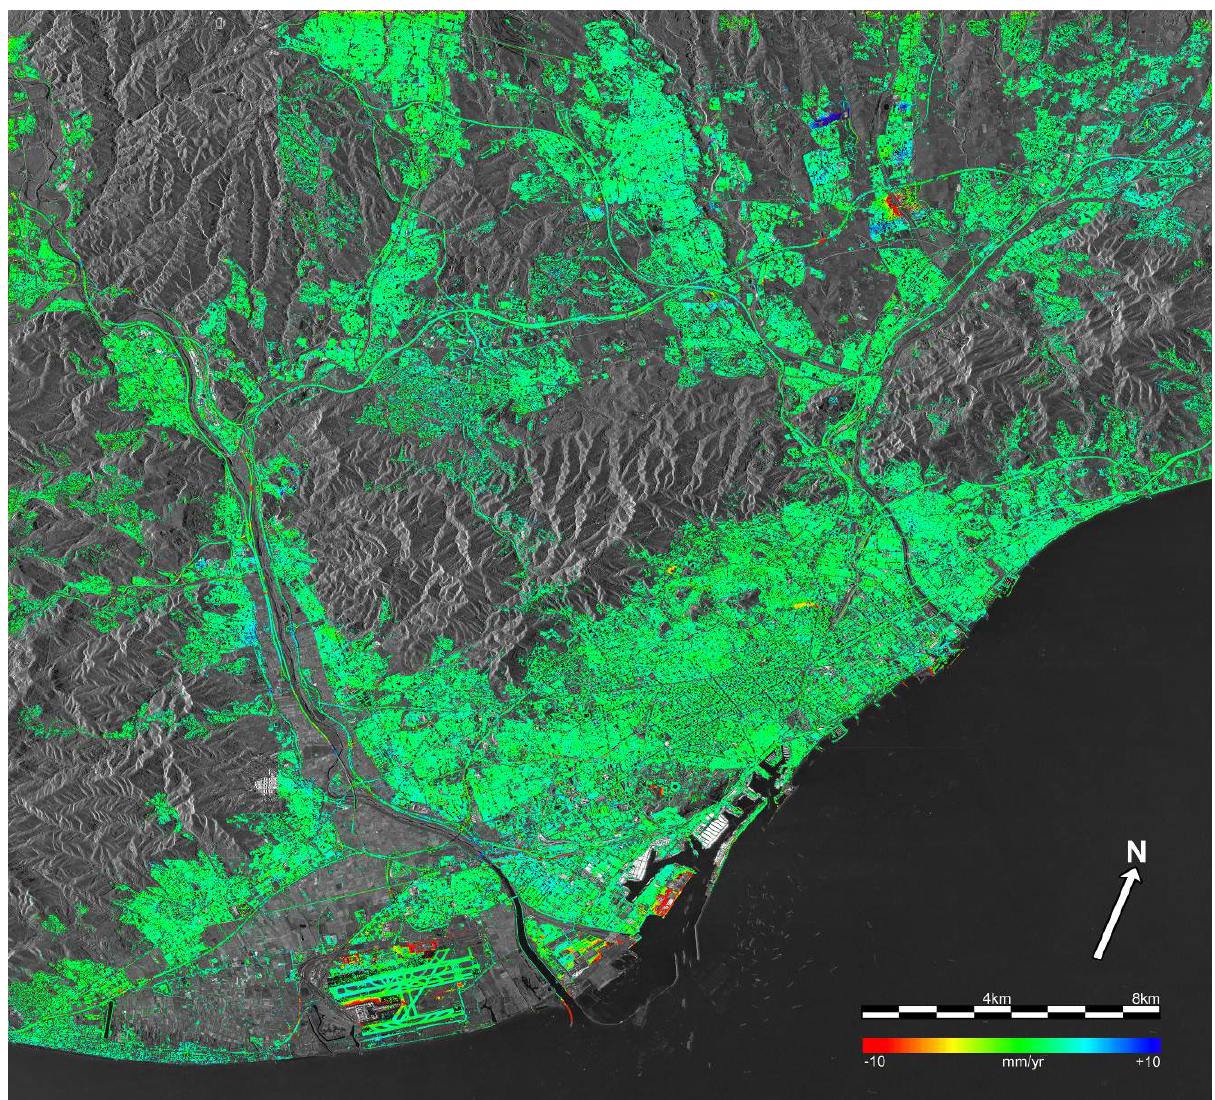
Figure 1: Deformation velocity map of the Barcelona dataset superposed to a mean SAR amplitude image. It includes more than 5.4 million PSs and covers 1019 km 2